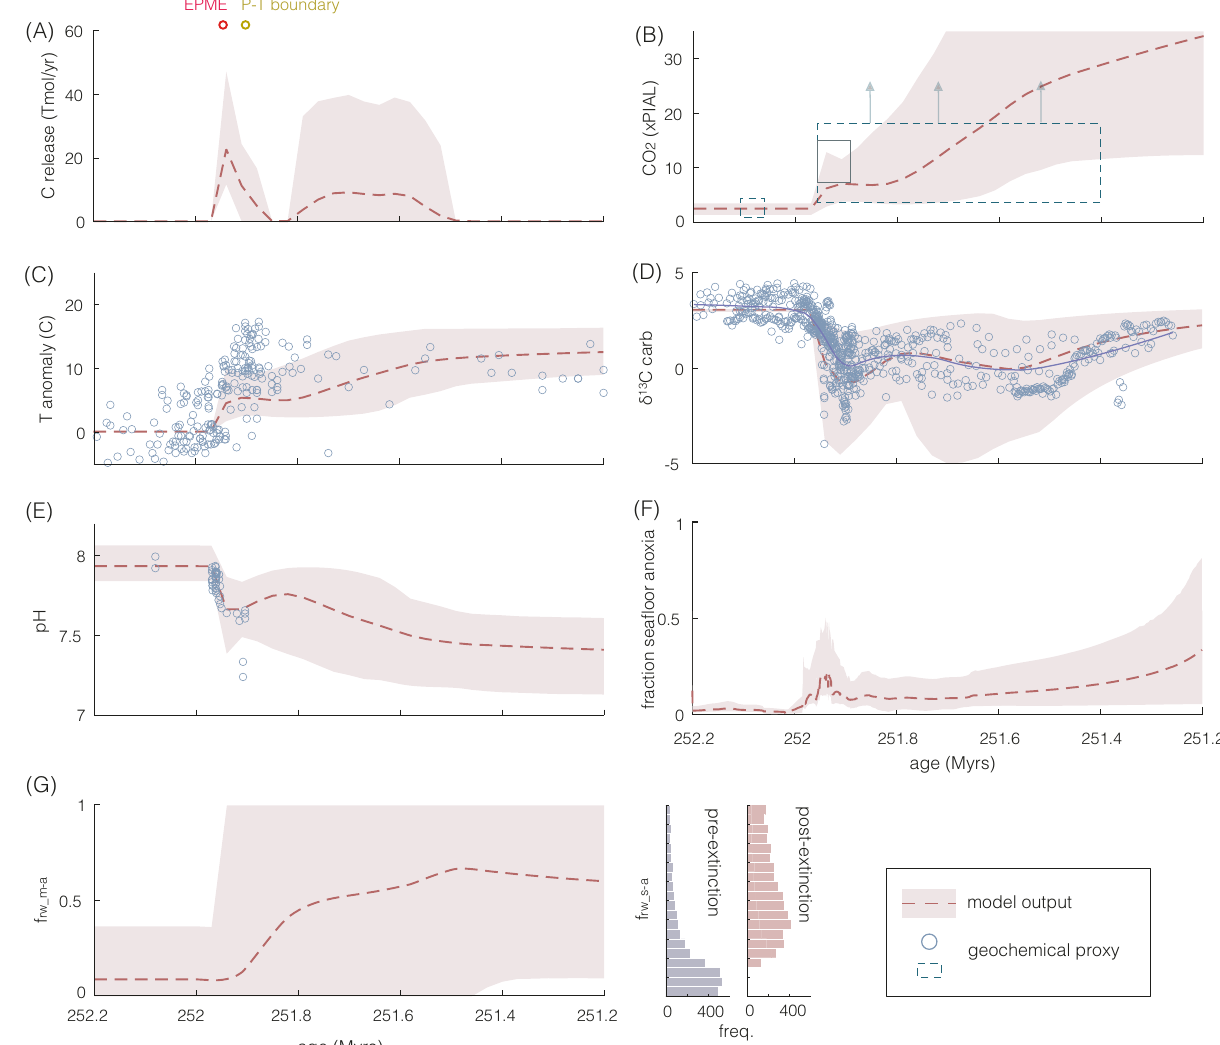
Fig. 7 Successful modeling results from Simulation 2 reproducing geochemical proxy data at the end-Permian mass extinction (EPME). Red dashed line indicates the average model output, and 95% of the data falls within the pink envelope. Input parameters follow that of Fig. 1. A Carbon released from solid Earth (volcanic) and sedimentary metamorphic degassing fl uxes (Tmol/yr); B atmospheric p CO 2 (×PIAL) levels, dashed gray boxes indicate proxy estimates from stomata 60,61 , paleosol carbonates 62,63 , phytane 64 and δ 13 C of plant matter 4 ; the upper estimate of the dashed boxes indicate the minimum values (as indicated by the up arrows) given that both stomatal index and the Δδ 13 C plant proxy saturate at ~800 and 2500 ppm, respectively 91,92 (i.e., proxies are not sensitive to higher p CO 2 beyond this level); the solid gray box indicates estimates from boron isotope data 11 ; C temperature anomaly, sea surface temperature reconstructions (blue circles) 2,32,33 with age constraints based on 9,87 ; D δ 13 C carb (ref. 4 ), model reconstruction represent the δ 13 C of surface DIC offset by + 0.5 ‰ ; E marine pH (ref. 11 ); F fraction sea fl oor anoxia derived from 93 ; G f rw_m-a (left) and f rw_s-a (right) as presented in Fig.